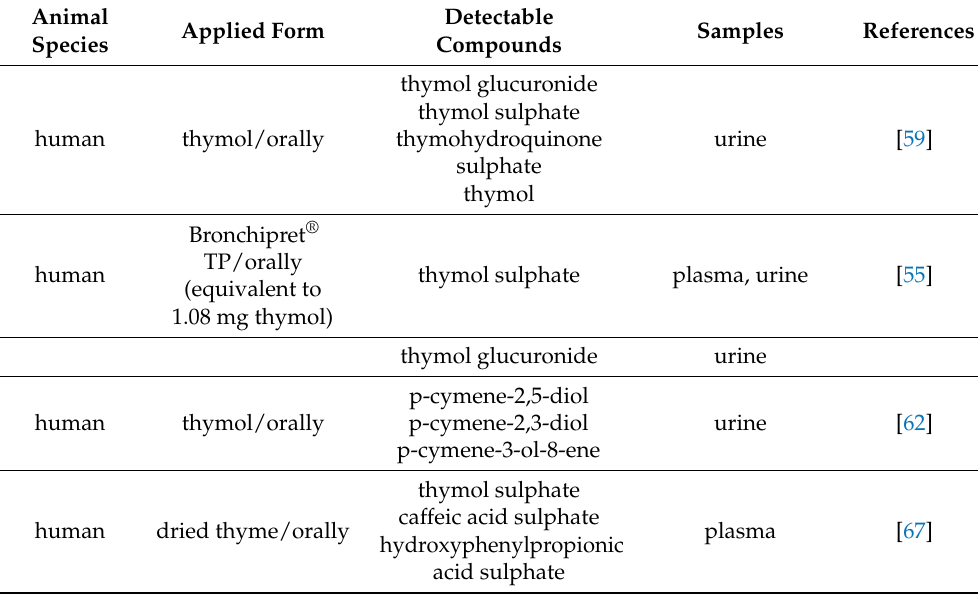
Table 1. Detection of thymol and its metabolites in the bodies of humans and animals.